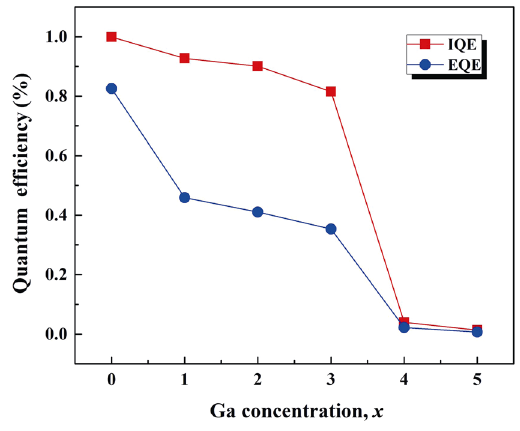
Fig. 8 Quantum efficiency for Y 3 Al 5– x Ga x O 12 :Ce ( x = 0–5) ceramics.